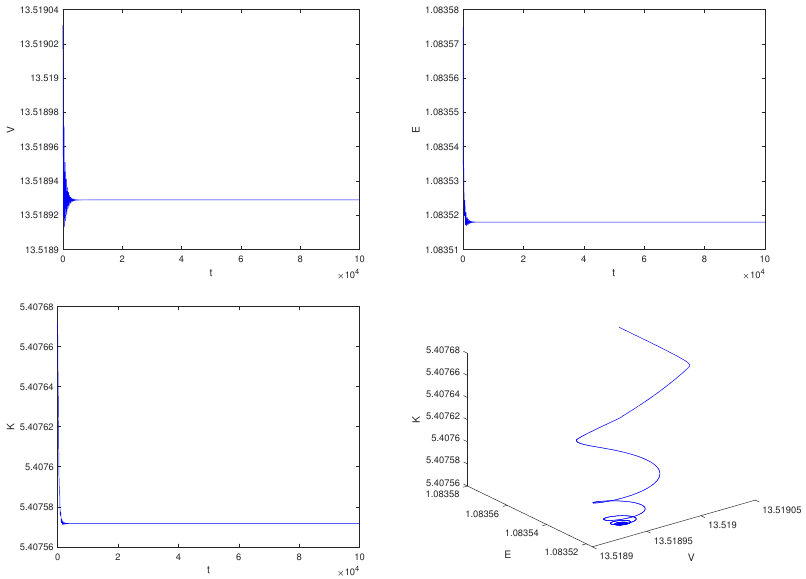
Figure 3. The phase graph and the trajectories of system ( 4 ) with τ 1 = 1.00, τ 2 = 1.80, S ∗ is asymptotically stable.